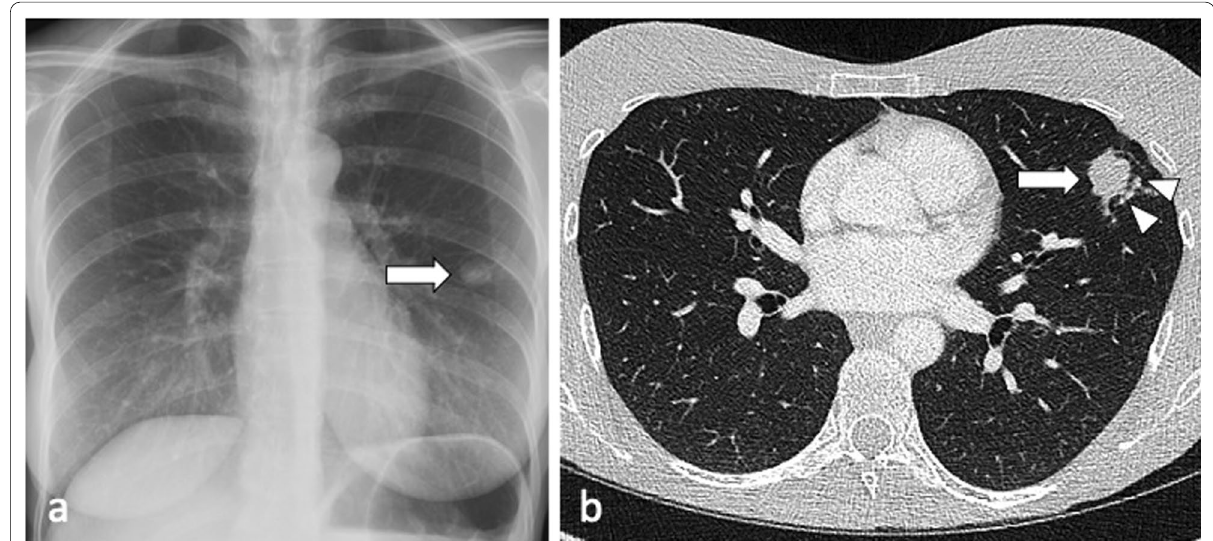
Fig. 1 A 37-year-old female had a routine chest radiograph ( a ) which demonstrated a solitary pulmonary nodule in the left mid zone (arrow). CT (lung window, axial plane—( b ) confirms the presence of a 27 mm nodule in the lingula (arrow) with adjacent tiny satellite nodules (arrowheads) but no lymphadenopathy. Sputum smears were negative but TB culture from bronchoalveolar lavage was positive for M.